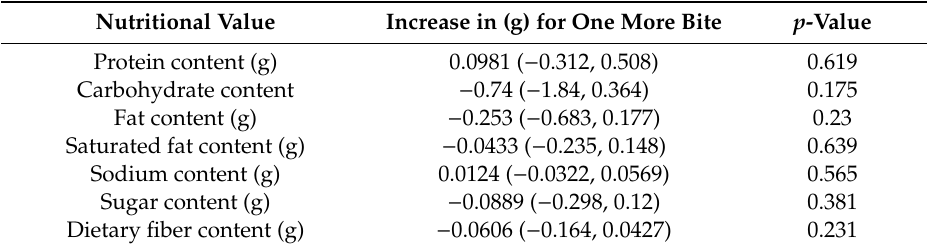
Table 5. Association between the number of bites and nutritional values. Numbers are reported as the increase in (g) for one more bite (95% C.I.).